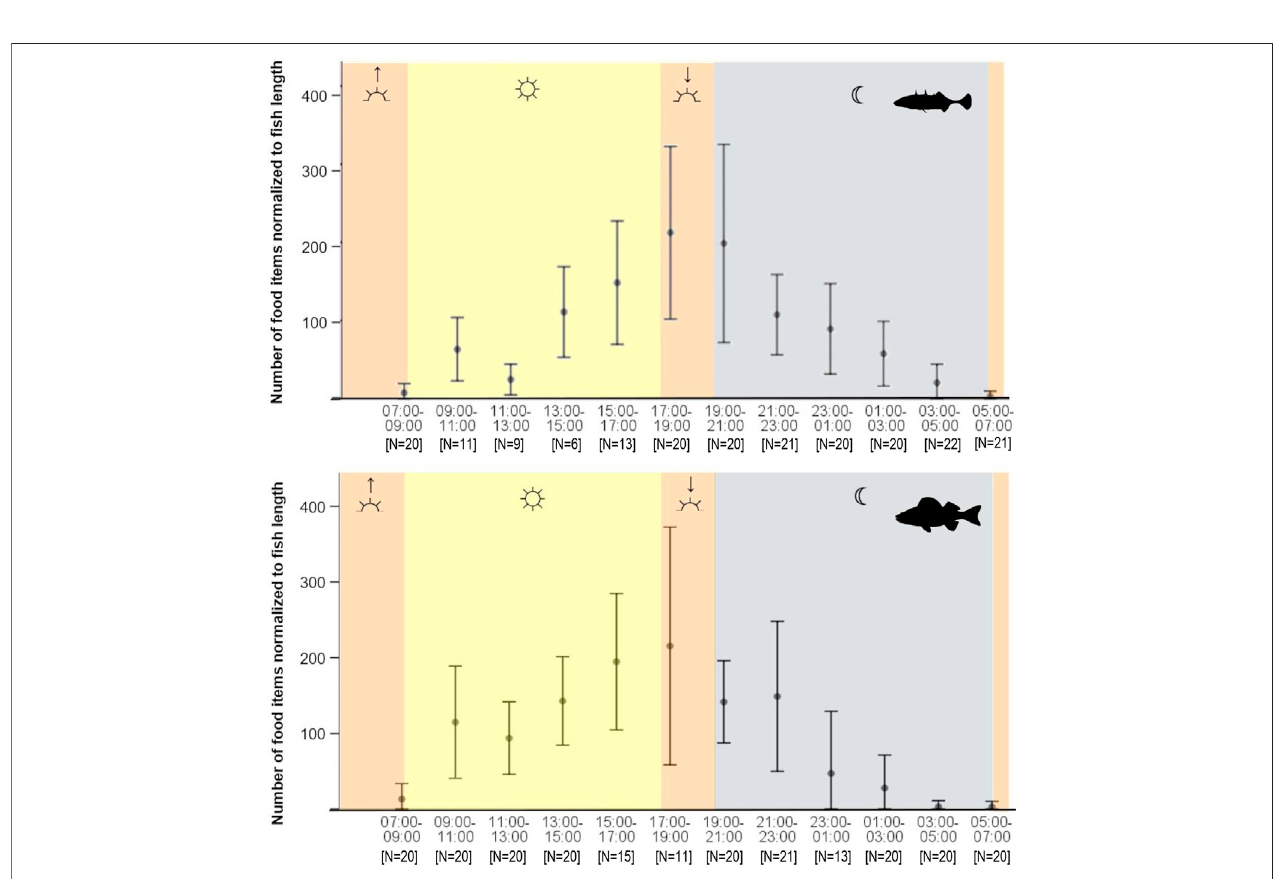
FIGURE 2 | Food items consumed by daytime of stickleback (top) and perch (bottom) from Lake Constance in autumn (mean ± SD). The approximate times of twilights (dusk and dawn) are shown as orange areas, nighttime is marked grey and daylight hours yellow.